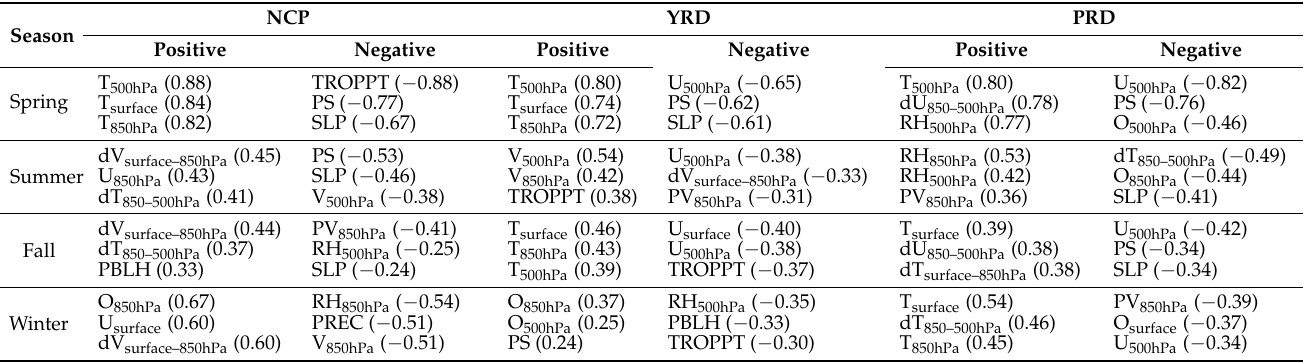
Table 4. Meteorological elements that have the strongest correlation with r PM-AOD in NCP, YRD and